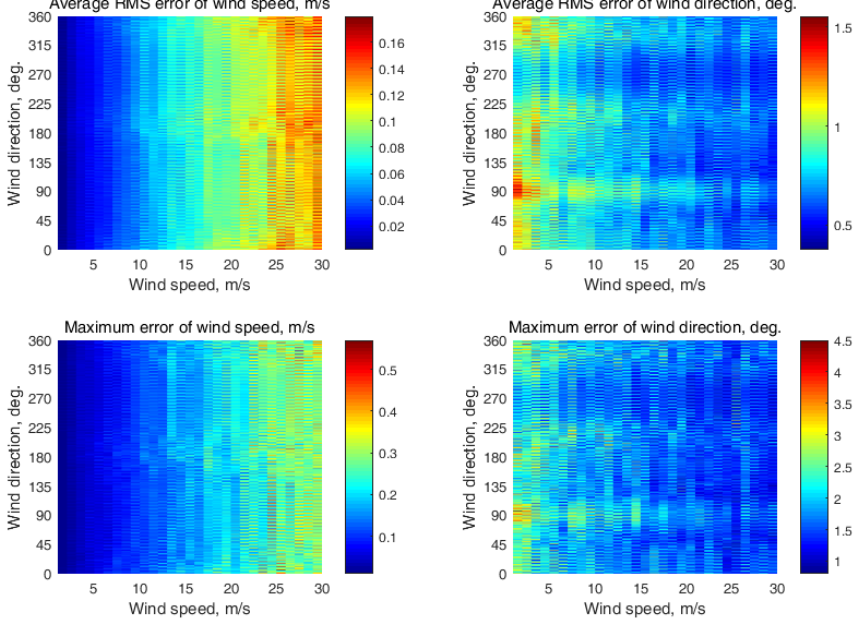
Figure A21. Semicircular wind retrieval results at the (35°, 40°, 45°, 50°) incidence angle combina- tion.